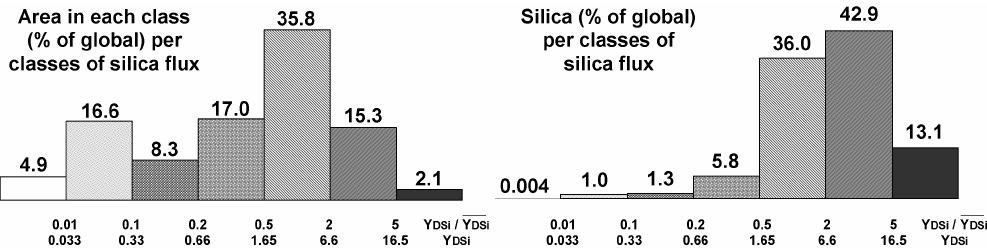
Fig. 5. Relative distribution of dissolved silica yields in exorheic basins (115Mkm 2 , n ≈ 140). Classes are constructed after the mean yield of 3.3tDSikm − 2 yr − 1 (see text). Antarctica and glaciated parts of Greenland not